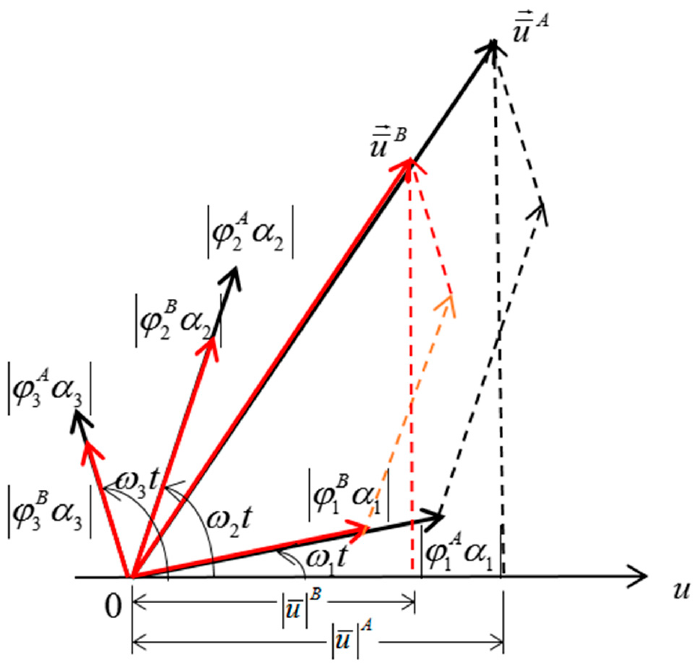
Figure 3. The diagram of the collinear synthesis motions by three modes.